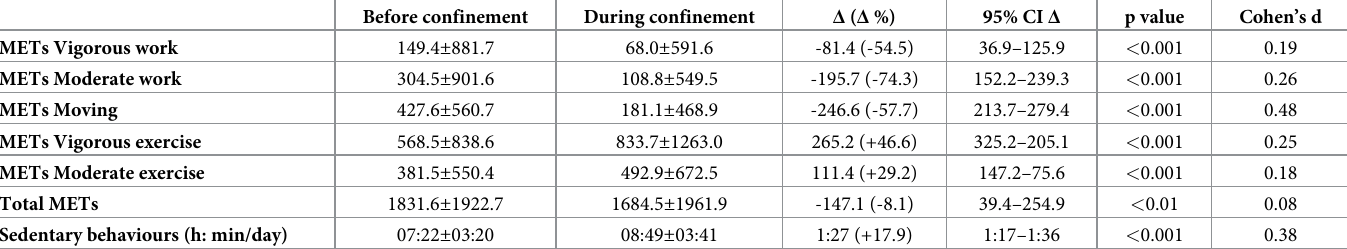
Table 1. This is the weekly physical activity expressed as METs at work (vigorous and moderate), during transport activities (moving) and recreational exercise (vig- orous and moderate), as well as daily time spent in sedentary behaviours. All values are compared before and during the quarantine period. Before